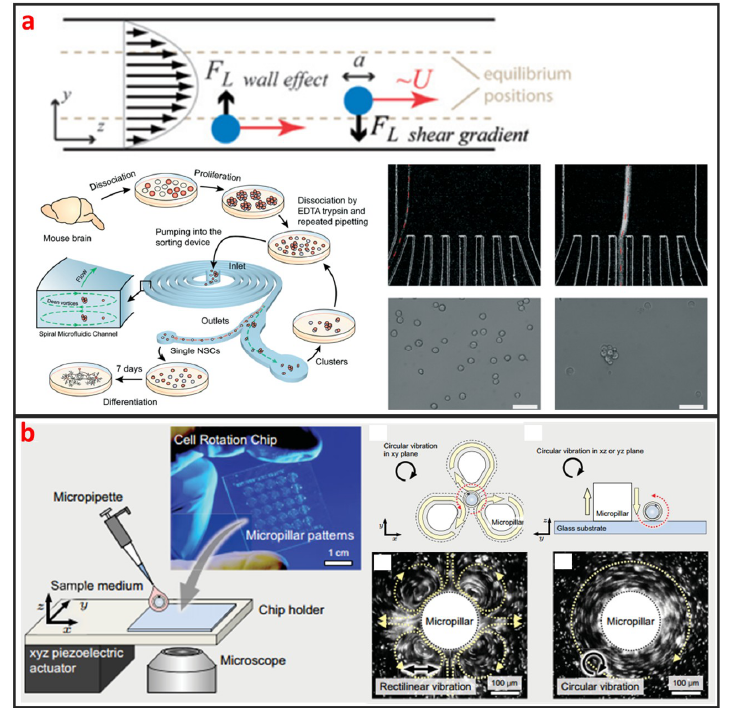
Figure 2. Inertial and vortex microfluidic single-cell manipulation and some designs. ( a ) Inertial microchannel to separate single-cell from cell cluster. Adapted by permission from References [52,55], copyright Royal Society of Chemistry 2009 and 2015. ( b ) Vortex generated by micropillar to rotate single-cell. Adapted by permission from Reference [58], under the Creative Commons Attribution License 2015.